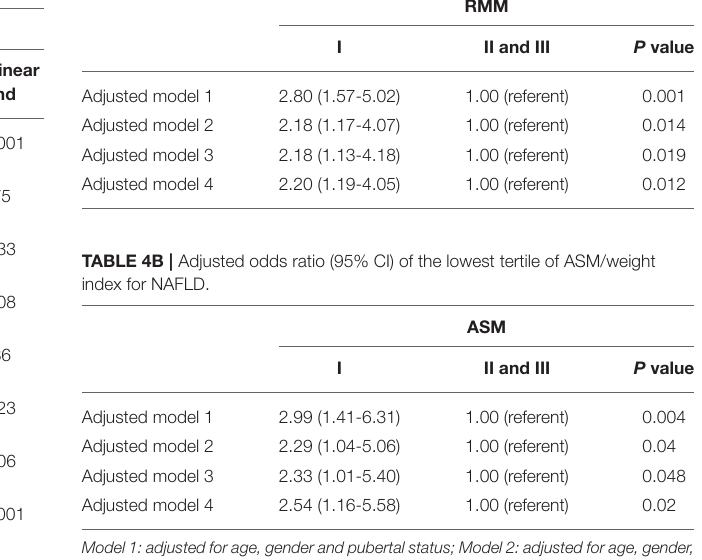
Model1:adjustedforage,genderandpubertalstatus;Model2:adjustedforage,gender, pubertal status, and central obesity; Model 3: adjusted for age, gender, pubertal status, central obesity, high blood pressure, elevated triglycerides, low high-density lipoprotein cholesterol, and insulin resistance; Model 4: adjusted for age, gender, pubertal status and MetS. CI, confidence